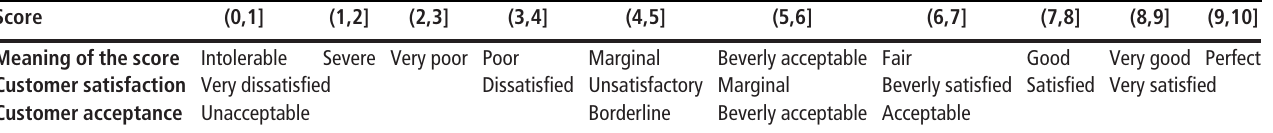
Table A1 Rating scale from SAE J1060 with a slight modi fi cation